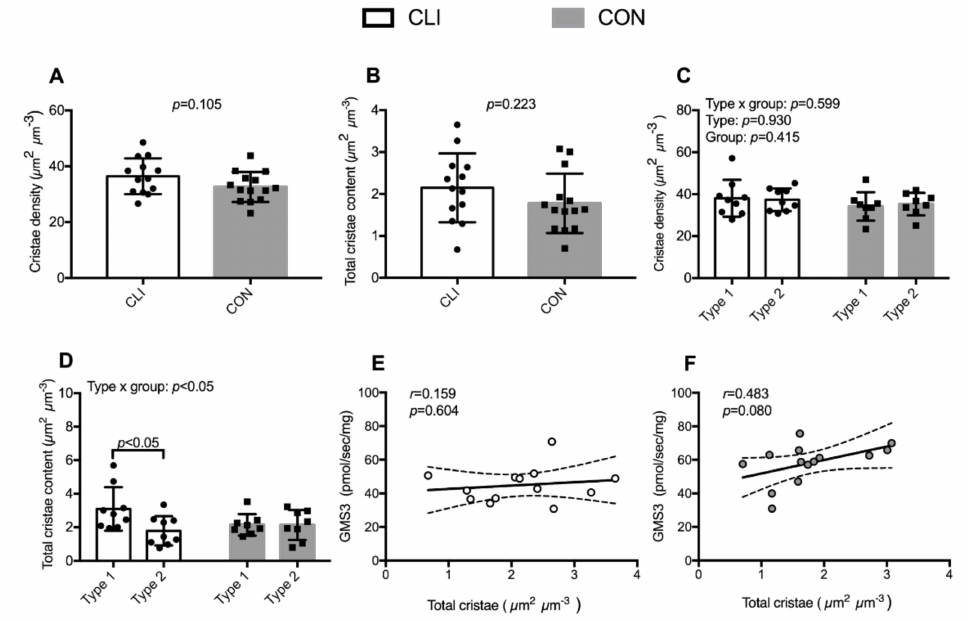
Figure 6. Whole-muscle (CLI: n = 13, CON: n = 14) and fiber-type-specific (CLI: n = 9, CON: n = 8) cristae density and content. ( A ) Whole-muscle cristae density, ( B ) fiber-type-specific cristae density, ( C ) whole-muscle total cristae content, and ( D ) fiber-type-specific total cristae content. Data are presented as means ± SD. Overall linear mixed model e ff ects are designated in the upper left corners of graphs B and D. Association of whole-muscle total cristae content and GMS3 respiration for ( E ) CLI patients and ( F ) CON. Data are presented as individual values with line of fit (95% CI). Pearson’s correlation coe ffi cient ( r ) and significance (p) are designated in upper left corners of the